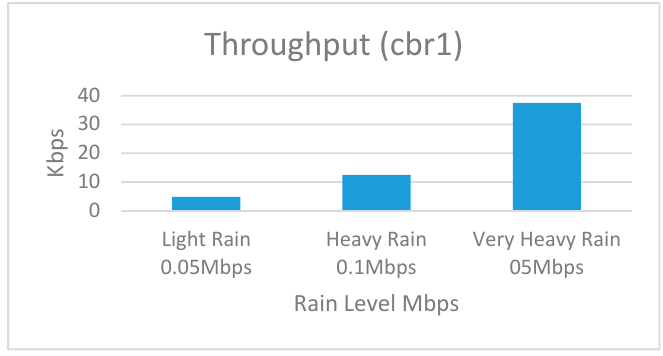
Figure 8. The throughput differences between light rain, heavy and very heavy rain, on node 1.